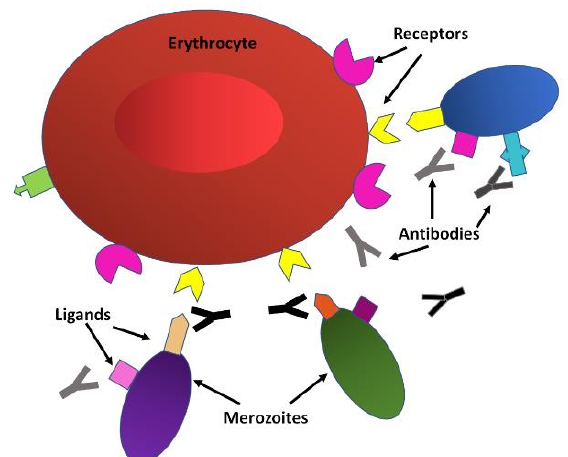
Figure 3. The blood cycle. Merozoites with different haplotypes (represented by different colours) of surface ligands (represented by different shapes) bind to erythrocyte receptors to start the invasion process. Erythrocytic stage vaccines aim to induce antibodies that recognise the parasite’s ligands to interfere with invasion and mediate the elimination of the parasite.